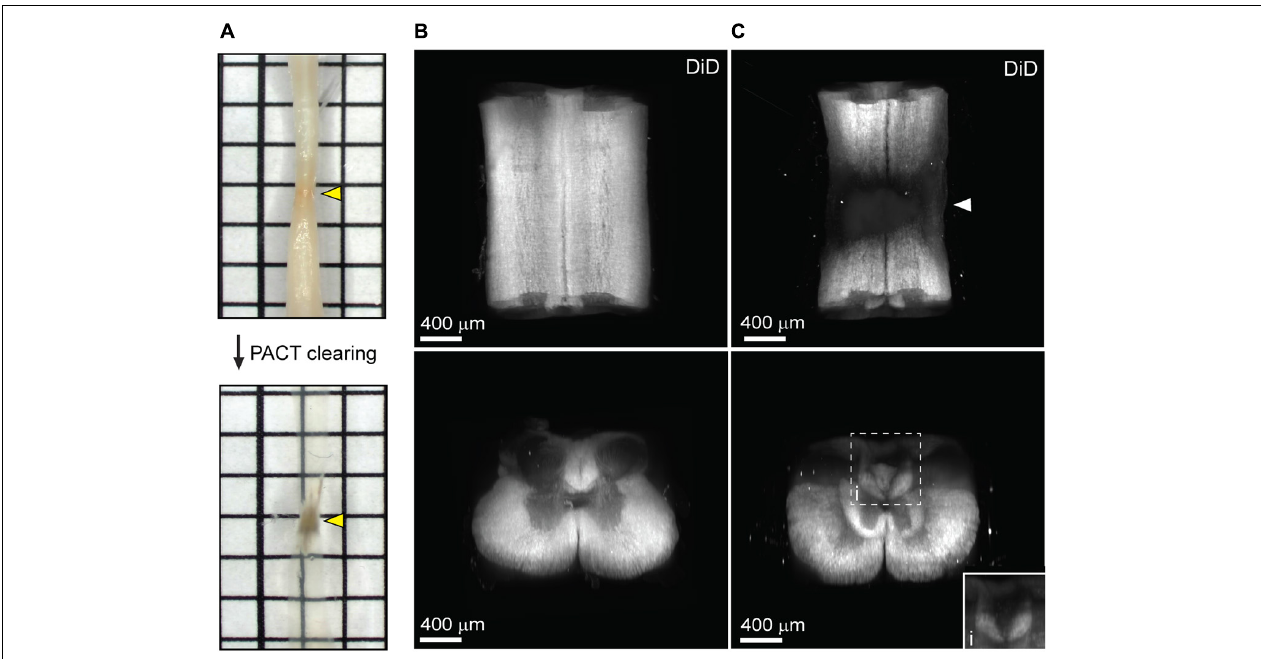
FIGURE 4 | Uniform white matter labeling following clearing of the long-term injured spinal cord. (A) PACT clearing of an injured spinal cord from a C57Bl/6 mice at 42 days post-SCI. Poor clearing of the SCI lesion (yellow arrows) does not prevent 3D imaging of the cleared surrounding tissue. (B) 3D projection of SWITCH-mediated DiD labeling of the intact spinal cord from the dorsal and transverse views, respectively. (C) 3D projection of SWITCH-mediated DiD labeling of the injured spinal cord (at 42 days post-SCI) from the dorsal and transverse views, respectively. Spared white matter tracks can be visualized around the SCI lesion site (white arrow). (i) Magnified view of DiD labeling in the dorsal column. SCI, spinal cord